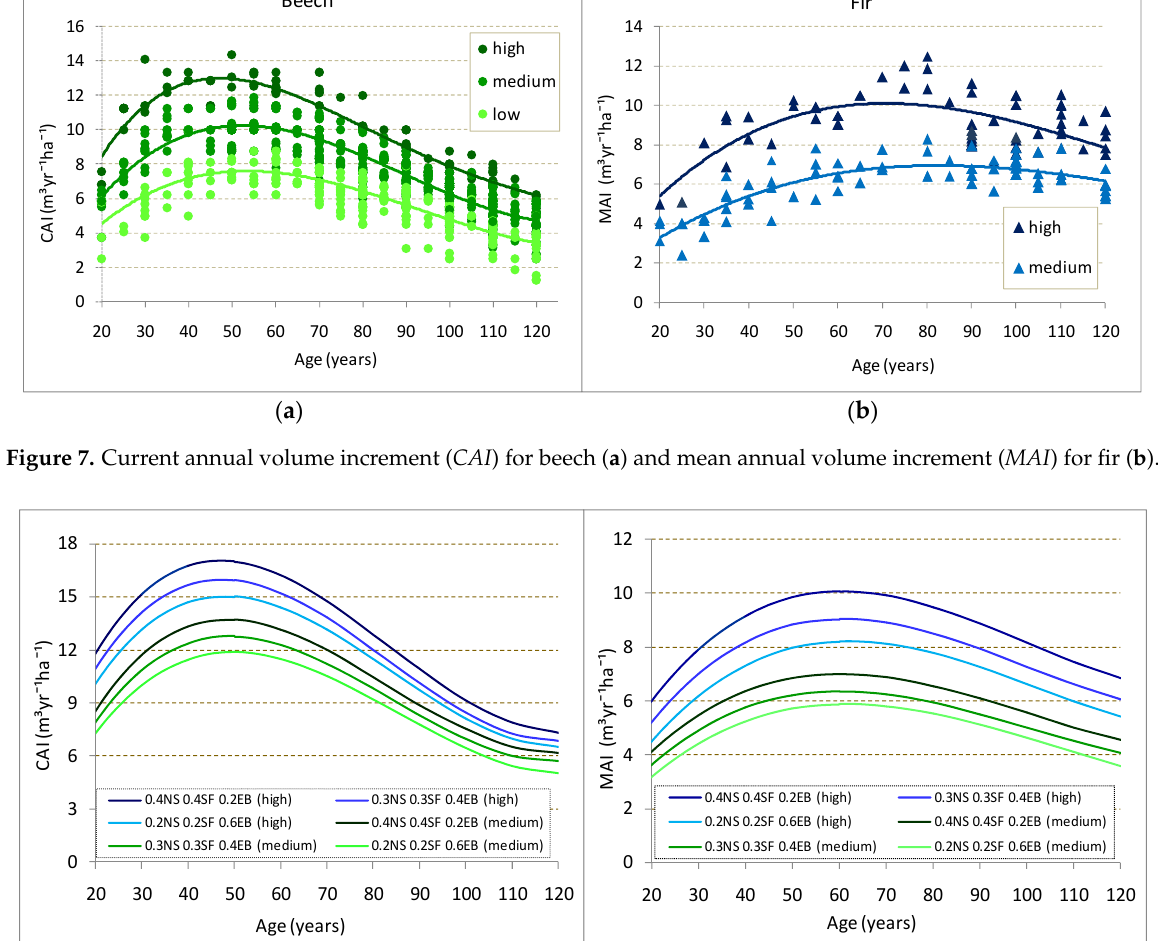
the following compositions 40%NS 40%SF 20%EB, 20%NS 20%SF 60%EB, 30%NS 30%SF 30%EB, located in medium–high